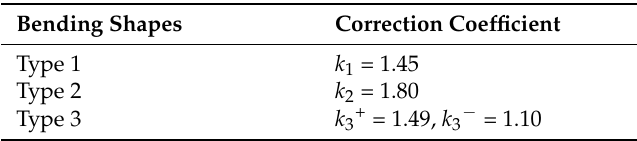
Table 3. Correction coefficients of each bending